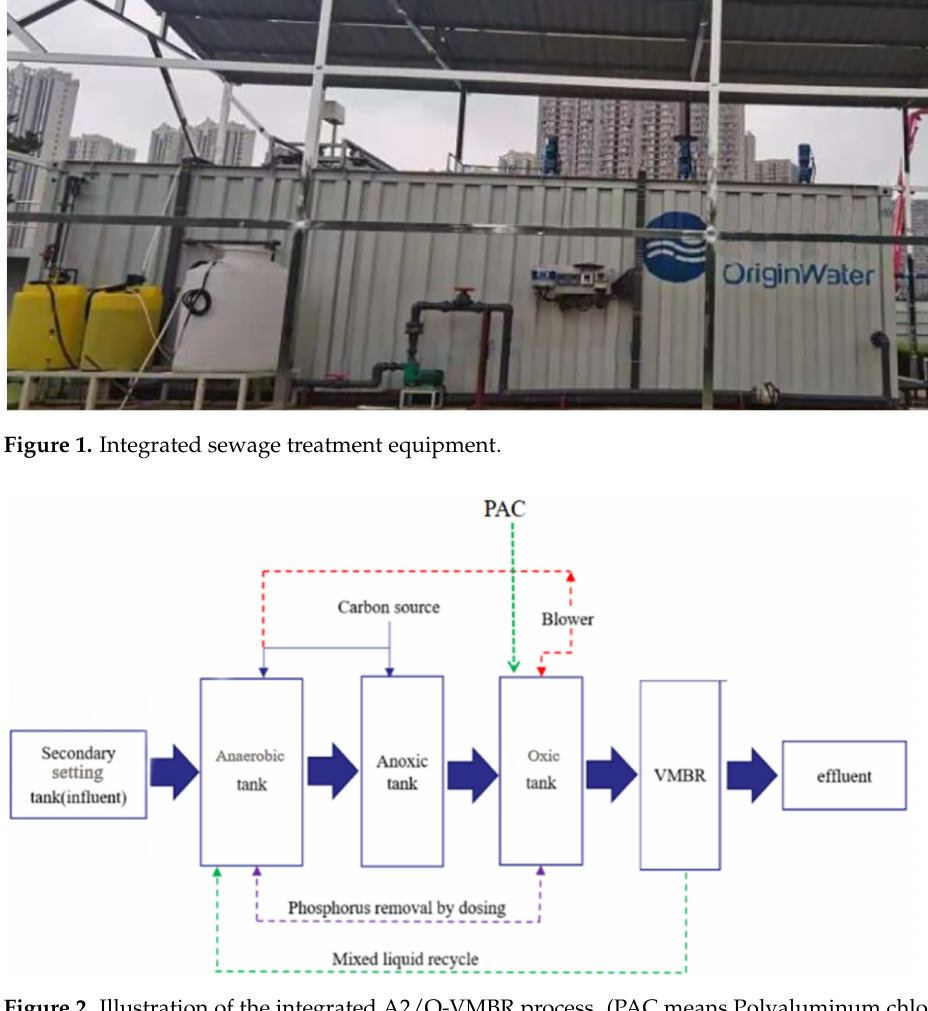
Figure 2. Illustration of the integrated A2/O-VMBR process. (PAC means Polyaluminum chloride.).